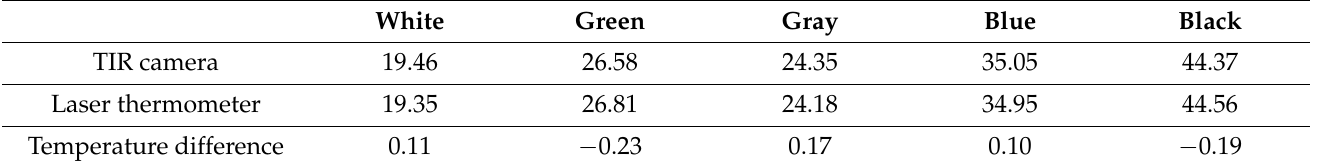
Table 3. Comparison between measured temperatures using a laser thermometer and a UAV-mounted TIR sensor ( ◦ C). White Green Gray Blue Black TIR camera Laser thermometer Temperature